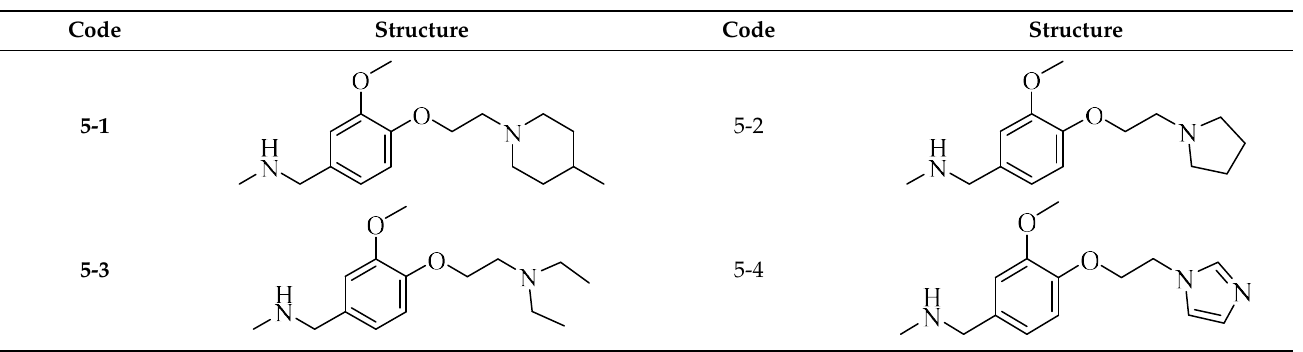
Table 1. The structures of intermediate compounds ( 5 ).